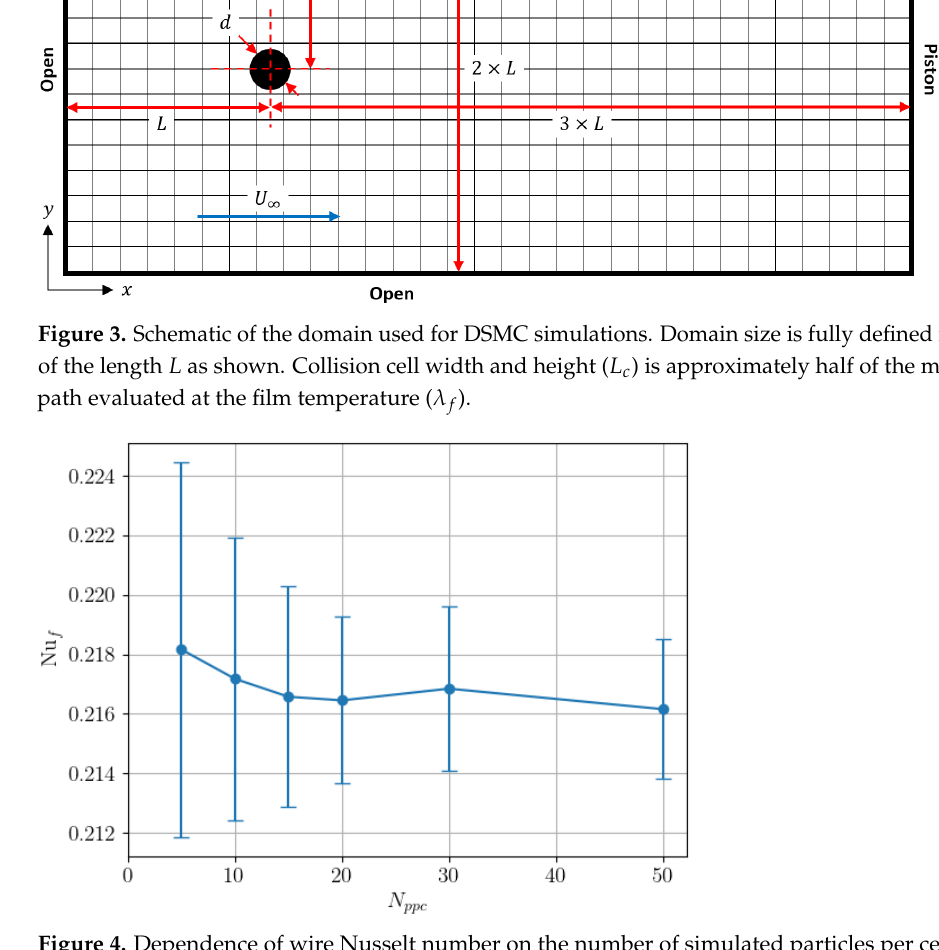
Figure 4. Dependence of wire Nusselt number on the number of simulated particles per cell. Error bars indicate ± 1 σ of the steady-state DSMC